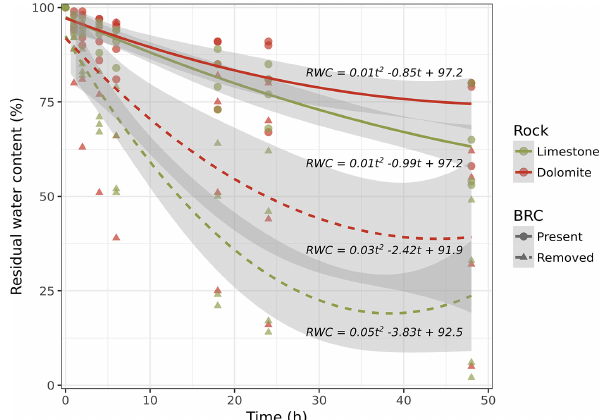
Figure 3. Desiccation of rock cores in the presence and absence of BRCs as a function of time, following full hydration. The curves indicate a second-degree polynomial line fitting (all fitted curves were significantly different from one another in ANOVA tests with P values<0.01 and R 2 values> 0 .